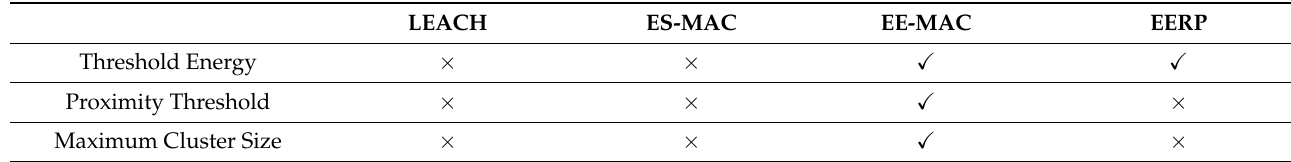
Table 3. Comparisons of